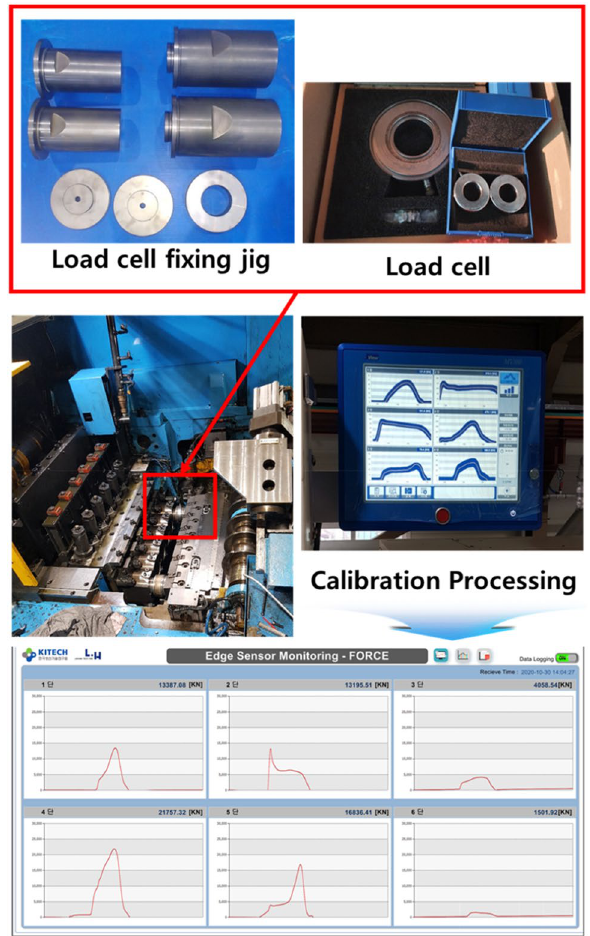
Figure 12. Load diagram conversion process and monitoring